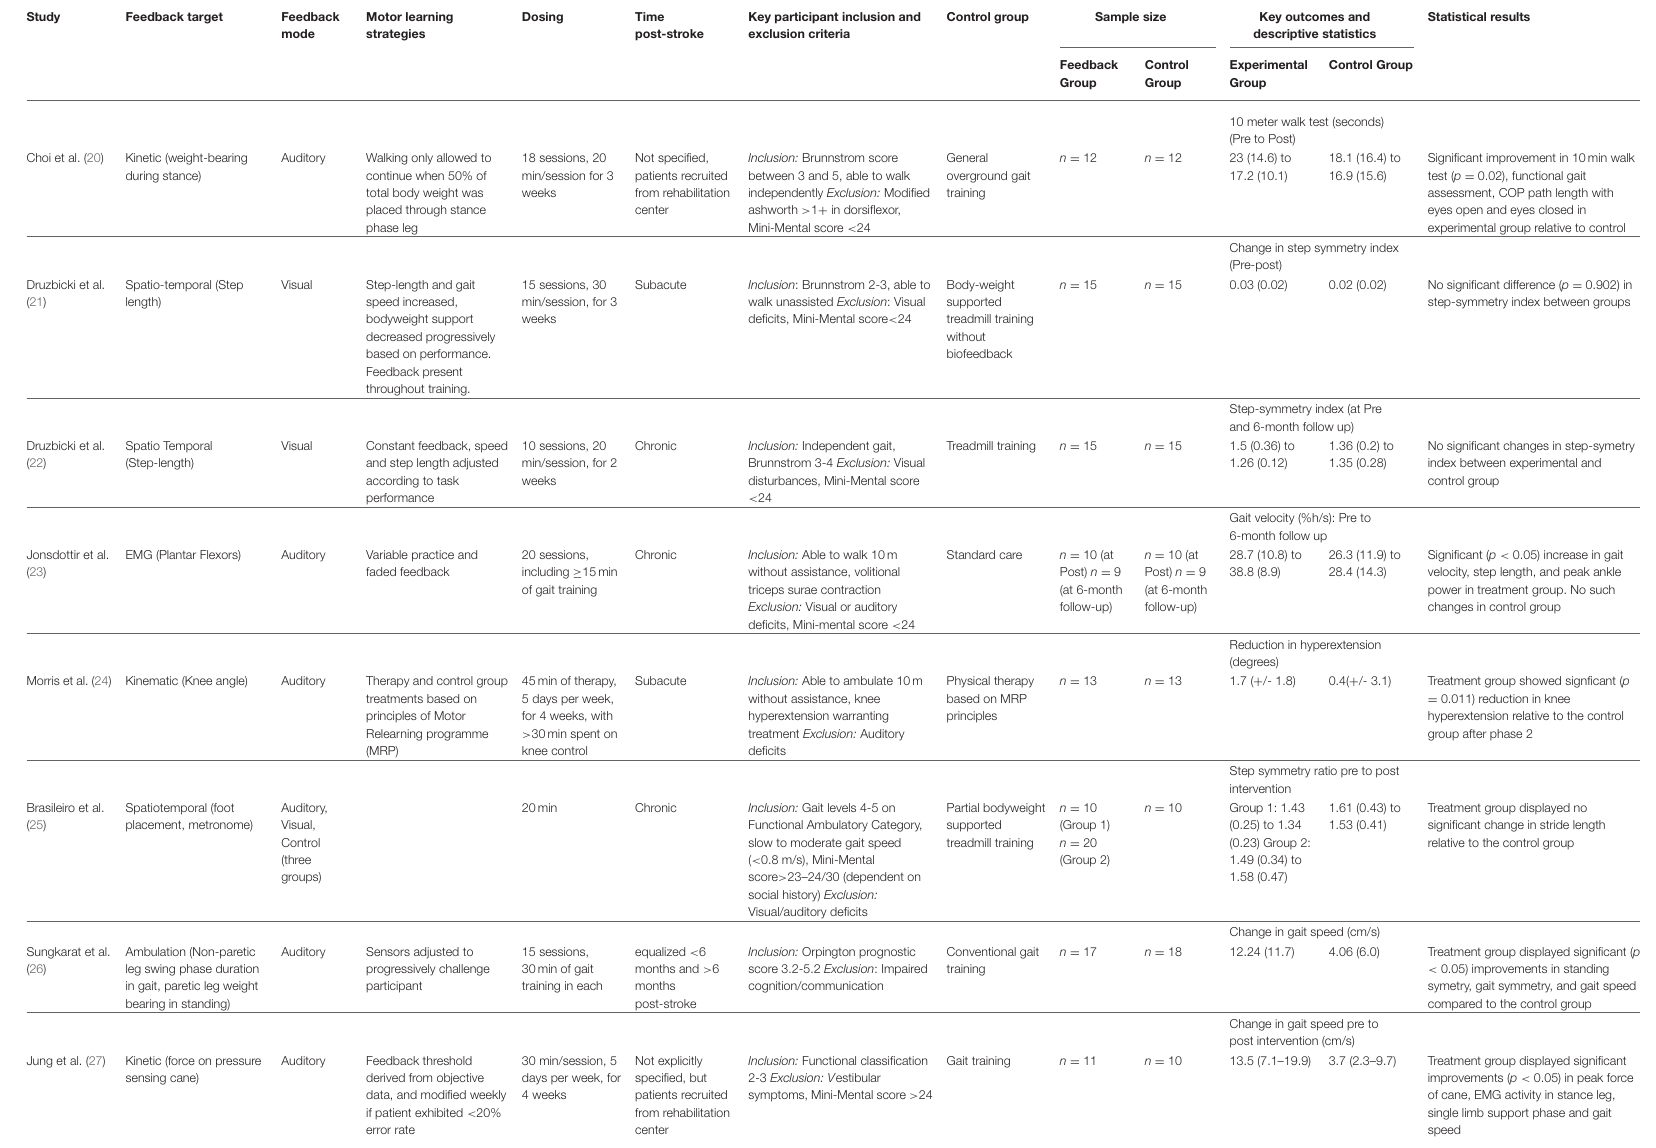
TABLE 1 | Summary of relevant characteristics of selected randomized control trials included in the review.